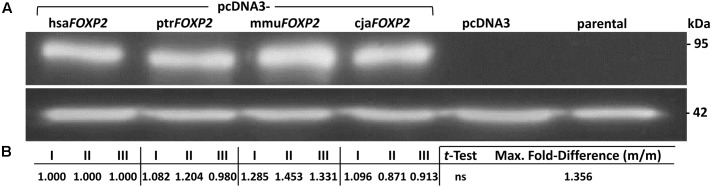
FOXP2 protein expression in SH-SY5Y cells. (A) Representative Western blot illustrating that anti-FOXP2 antibody detected no protein in parental cells, indicative of absent endogenous expression. Moreover, there was no FOXP2 detectable in cells carrying empty vector (pcDNA3). In contrast, bands were recognized in SH-SY5Y cells stably transfected with pcDNA3-hsaFOXP2, -ptrFOXP2, -mmuFOXP, and -cjaFOXP2 (all without FLAG tag), thereby indicating similar levels of exogenous FOXP2 expression. Purified lysates were run on an SDS-PAGE gel, transferred to PVDF membrane, and successively hybridized with the respective antibodies. Lower panel: β-actin served as a standard for protein load. (B) Densitometric analysis of FOXP2 levels. The given measurements refer to biological replicates I–III (with two technical replicates, each) of the conditions labeled in (A). Maximum (Max.) fold-difference corresponds to the ratio of the most extreme pair of mean expression levels (m/m) between hsaFOXP2-overexpressing cells and cells expressing non-human FOXP2 (here: mmuFOXP2). cja, marmoset (Callithrix jacchus); hsa, human (Homo sapiens); mmu, Rhesus monkey (Macaca mulatta); ptr, chimpanzee (Pan troglodytes).